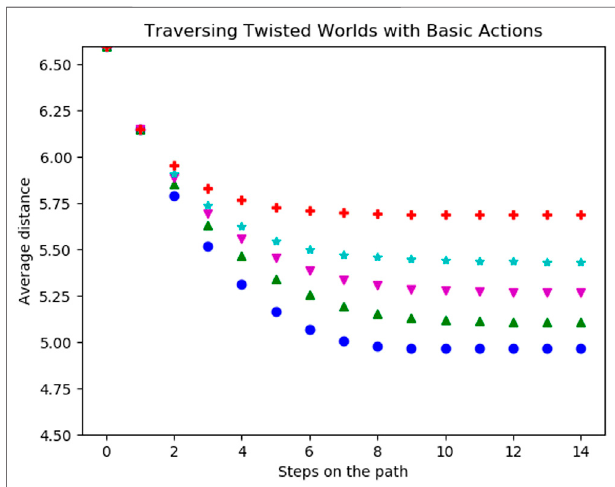
FIGURE 8 | Average distance ( V g ) of the possible goal states per step onthetrajectoryforallbasicactionsinworldswithdifferenttwistedness:0%in blue( C ),20%ingreen( ▲ ),30%inmagenta( ▼ ),50%incyan( + )and100%in red